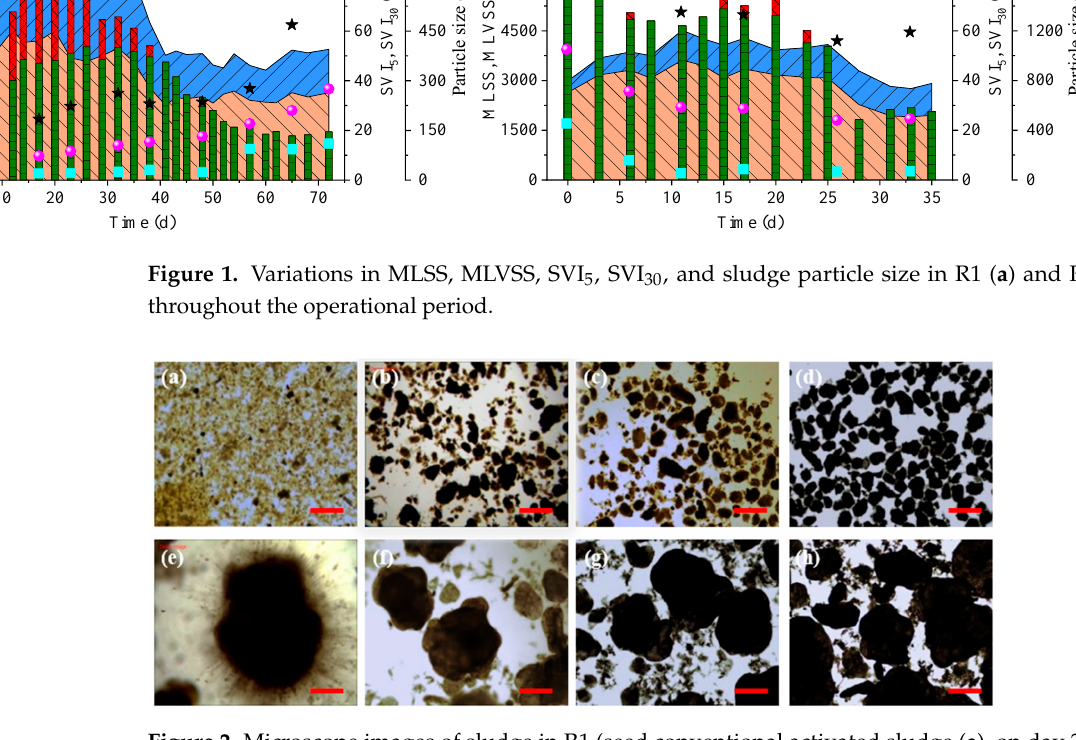
Figure 2. Microscope images of sludge in R1 (seed conventional activated sludge ( a ), on day 38 ( b ), day 61 ( c ), and day 68 ( d )) and R2 (seed aerobic granular sludge ( e ), on day 9 ( f ), day 19 ( g ), and day 29 ( h )) (scale bar (red) = 500 µ m).